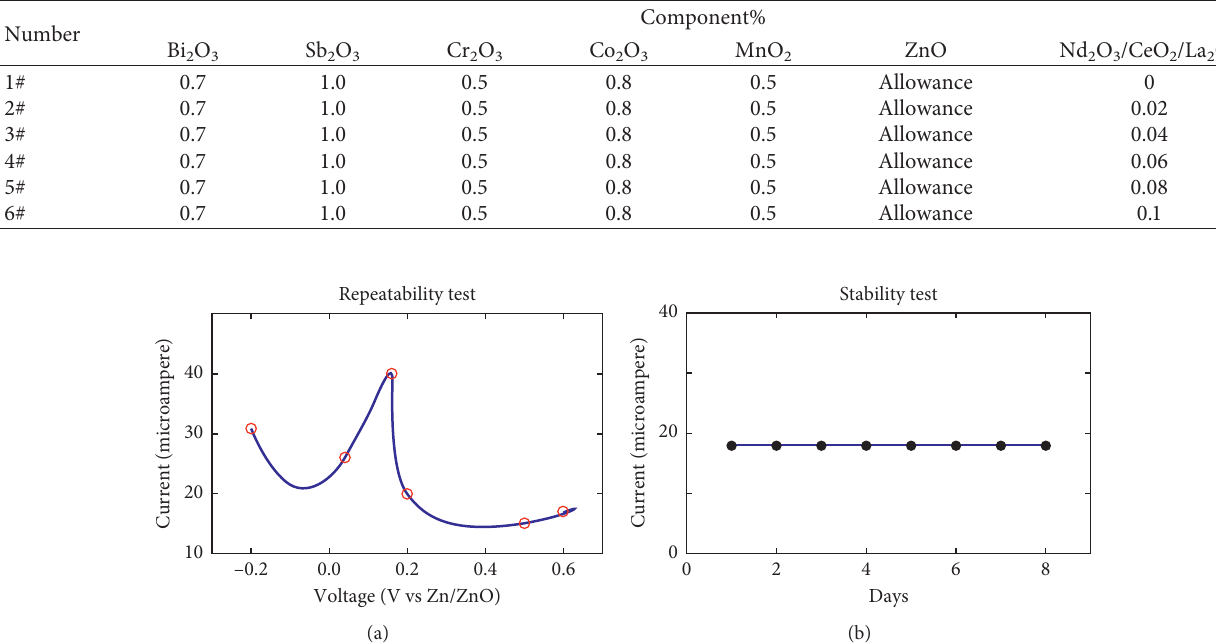
Table 1: Material composition.